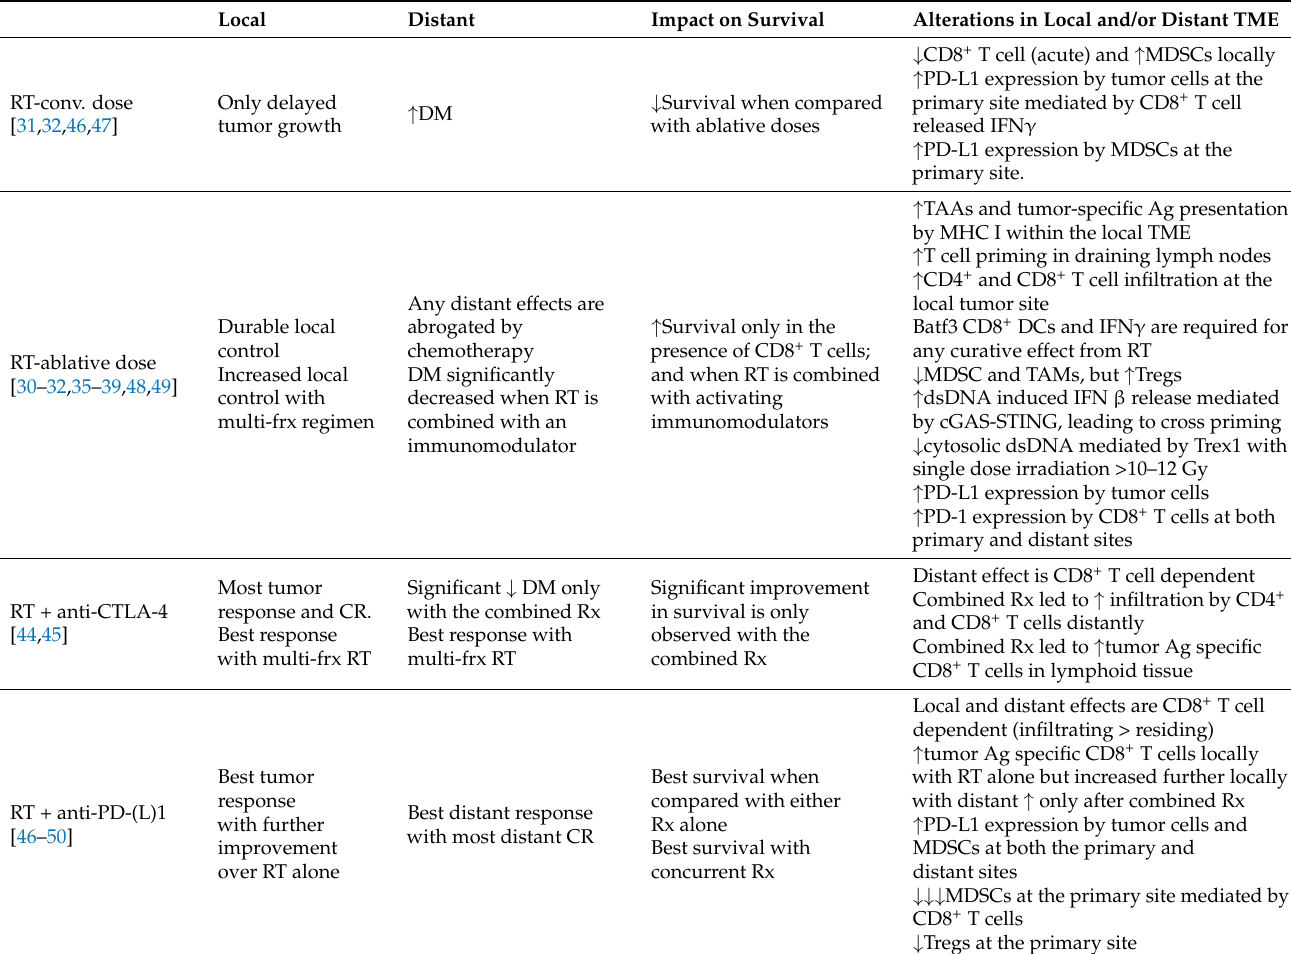
Table 3. Immunogenic effects of RT or RT and immune checkpoint inhibitor combinations observed in preclinical